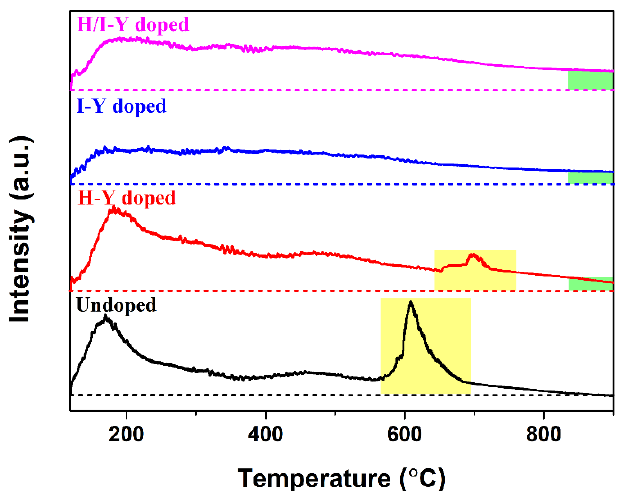
Figure 7. O 2 -TPD profiles of Undoped and H-Y-, I-Y-, and H/I-Y-doped CeO 2 powders. For comparison purposes, the OSC was quantified by the amount of O 2 desorption per gram of CeO 2 sample by measuring the corresponding peak areas of O 2 -TPD profiles. The quantified OSC values (labeled as [OSC]) of the Undoped and H-Y-, I-Y-, and H/I-Y-doped CeO 2 in the full temperature range are shown in Table 1. Compared with the OSC value of the Undoped CeO 2 , all of the Y-doped CeO 2 samples were enhanced, and the sequence of [OSC] was as follows: H-Y-doped CeO 2 (0.372 mmol/g) > H/I-Y-doped CeO 2 (0.353 mmol/g) > I-Y-doped CeO 2 (0.248 mmol/g) > Undoped CeO 2 (0.153 mmol/g). The OSC of the H-Y-, I-Y-, and H/I-Y-doped CeO 2 were increased by 143.1%, 62.1%, and 130.7%, respectively, compared with that of the Undoped CeO 2 . The enhanced OSC of all the Y-doped CeO 2 could be explained as follows: when Y 3+ ions were doped into the CeO 2 lattice to substitute Ce 4+ ions, the extrinsic V O defects were formed to keep the electric neutrality of their fluorite structure, accompanied by the increase in the number of oxidation/reduction cycles composed of Ce 3+ and Ce 4+ states (Ce 3+ ↔ Ce 4+ ). Y-doping